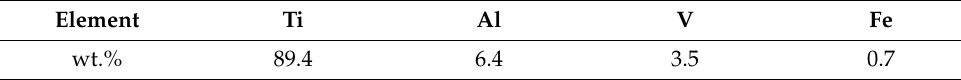
Table 1. Chemical composition of grade 5 titanium wire.